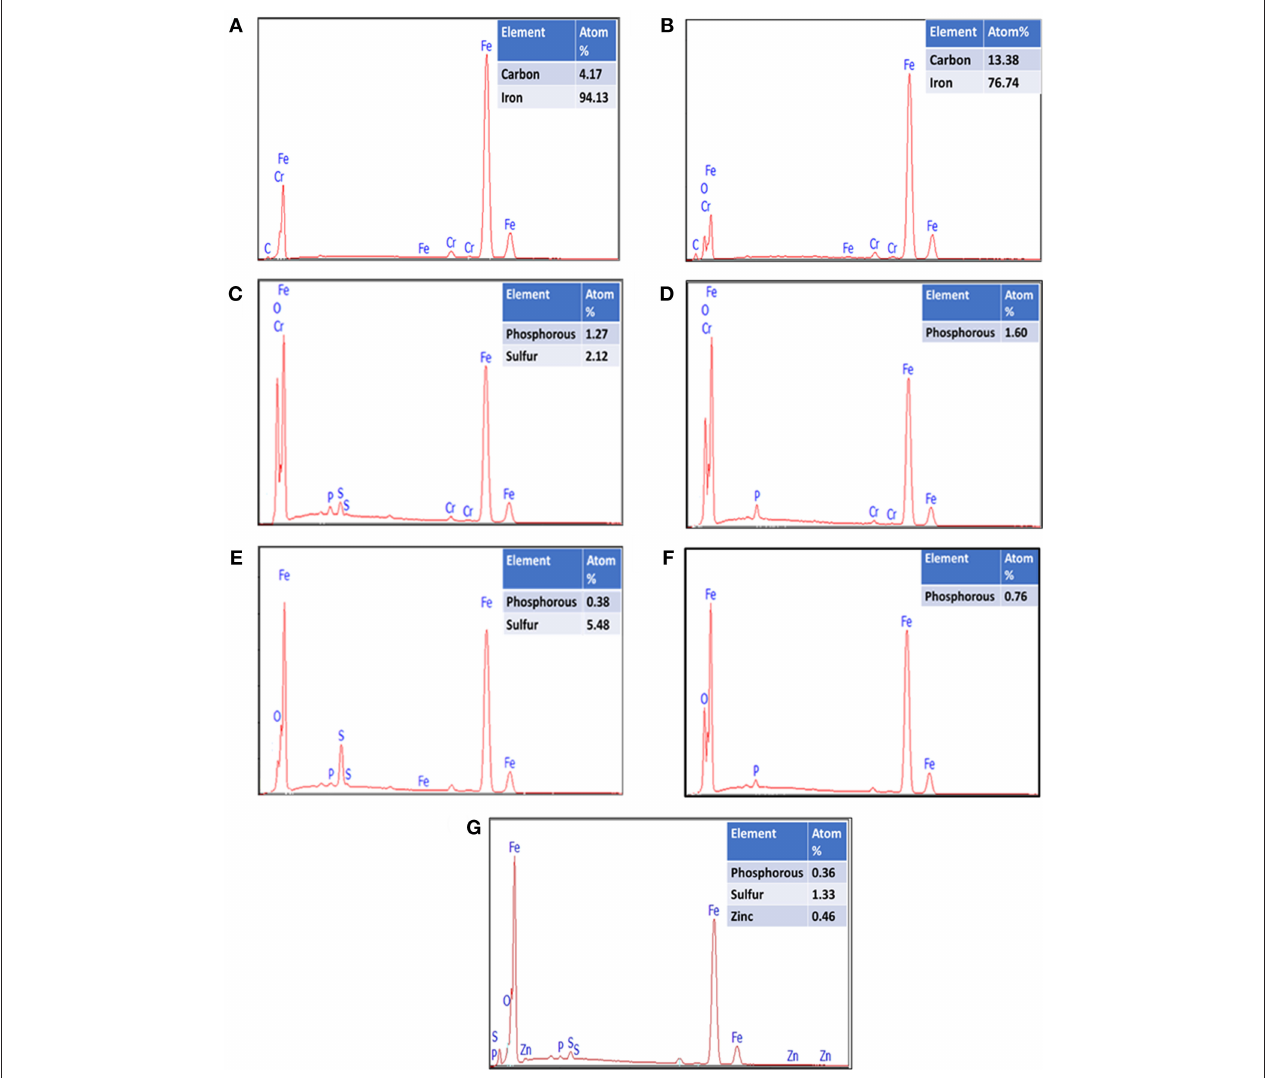
FIGURE 5 | Energy dispersive spectroscopy spectrum of four ball wear scars for grease blends with antiwear additives (A) Base Grease (B) MWCNT (C) P IL1 (D) P IL2 (E) N IL1 (F) N IL2 (G) ZDDP.